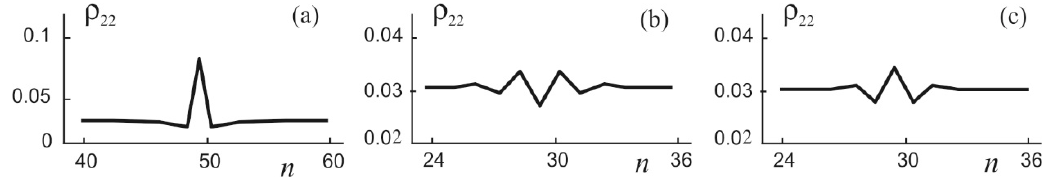
Figure 8. Profiles of the excited level population in the regime of narrow solitons.